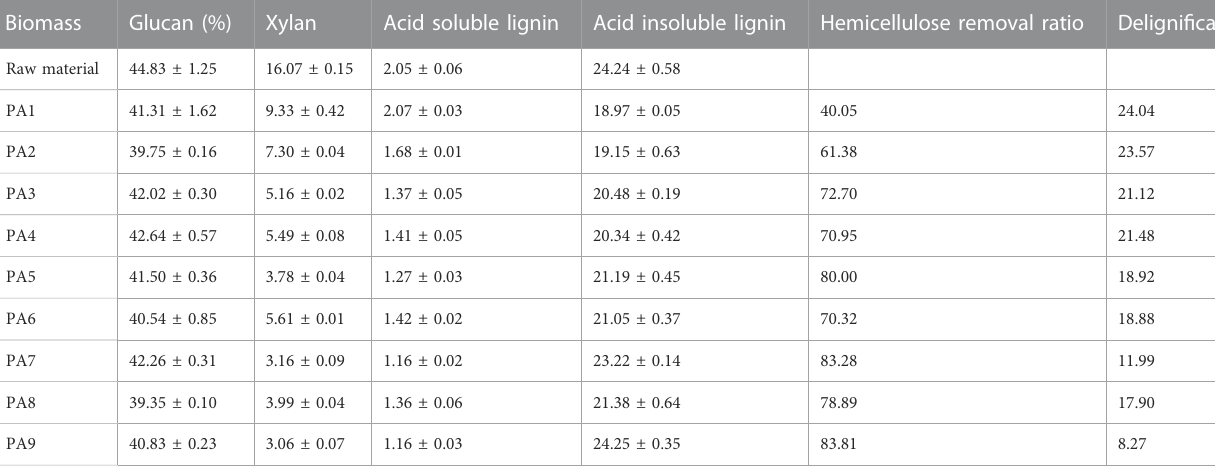
TABLE 4 Chemical compositions of phosphoric acid pretreated biomass. Biomass Glucan (%) Xylan Acid soluble lignin Acid insoluble lignin Raw